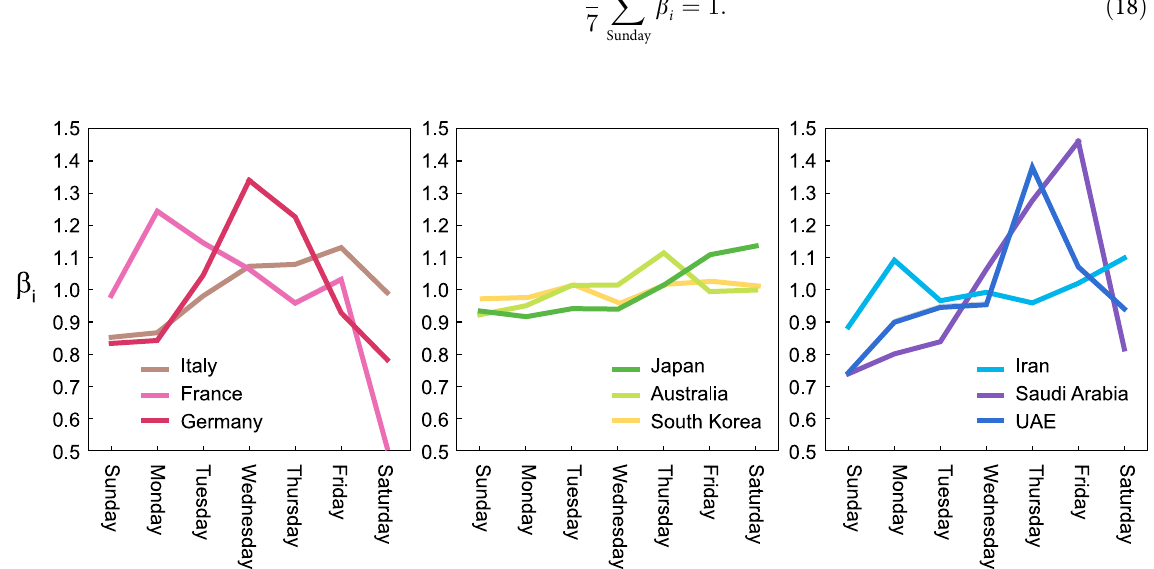
Fig 4. Variations by day of the week in the number of reported infections { β i } computed for several countries.